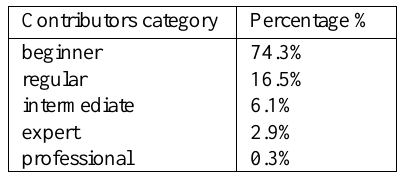
Table 1. Pattern of different OSM contributors according to the quality of their